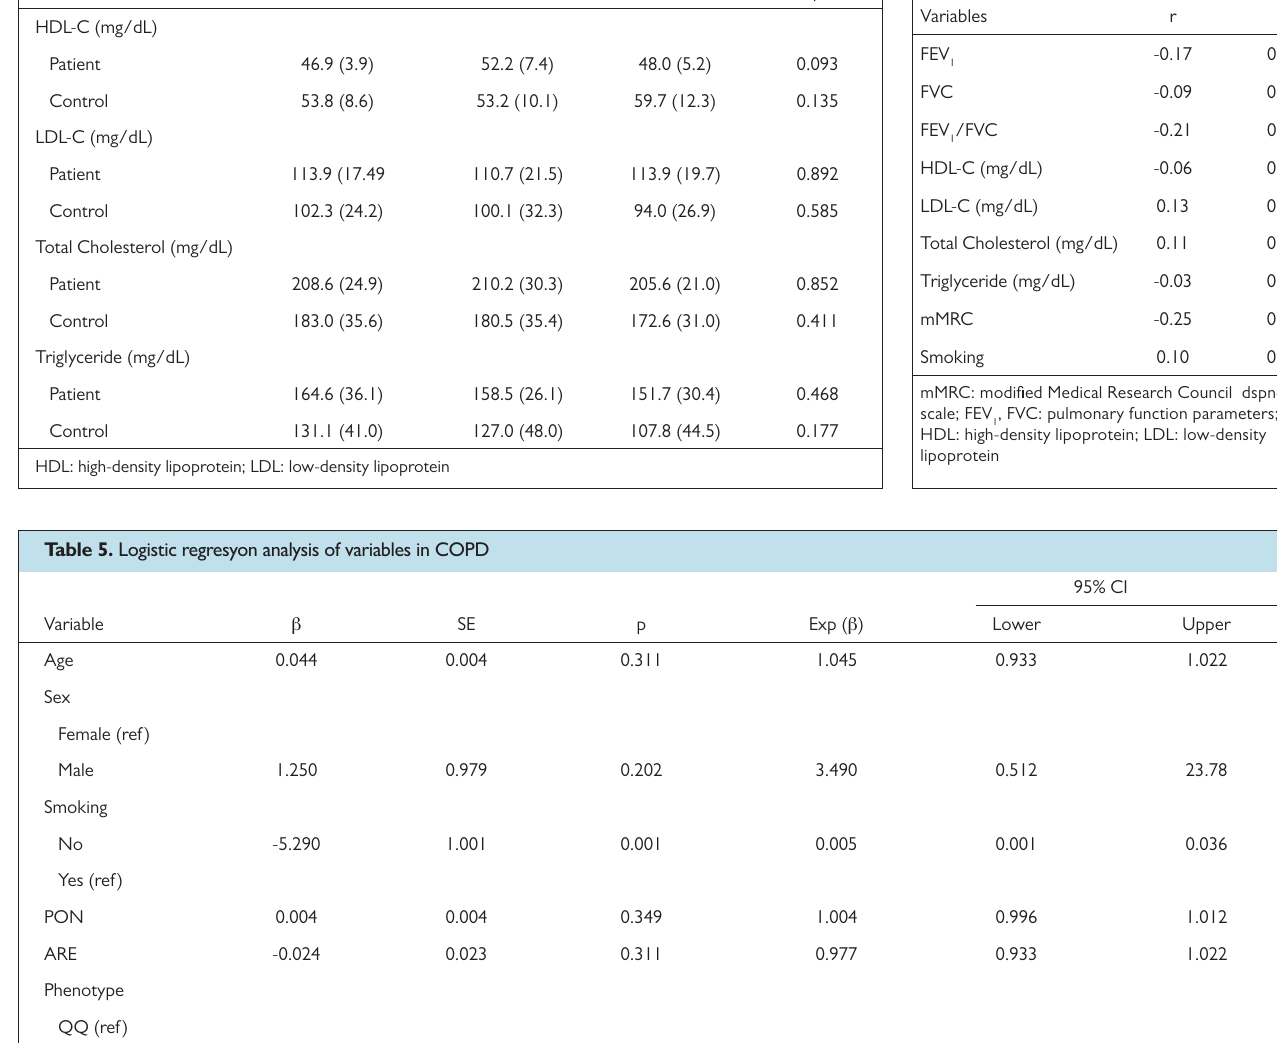
Table 4. Relation between PON1 activity and other parameters Variables